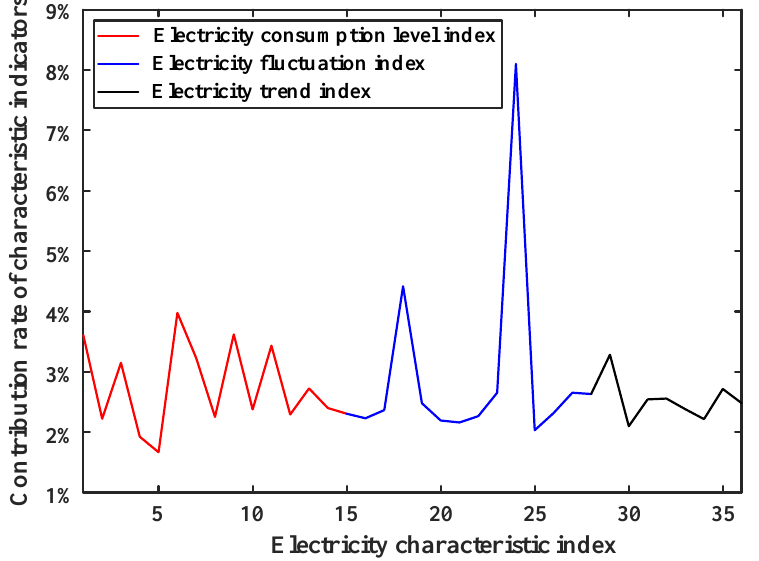
Figure 6. Contribution rate of different electricity characteristics to weighted random forest classifier performance.